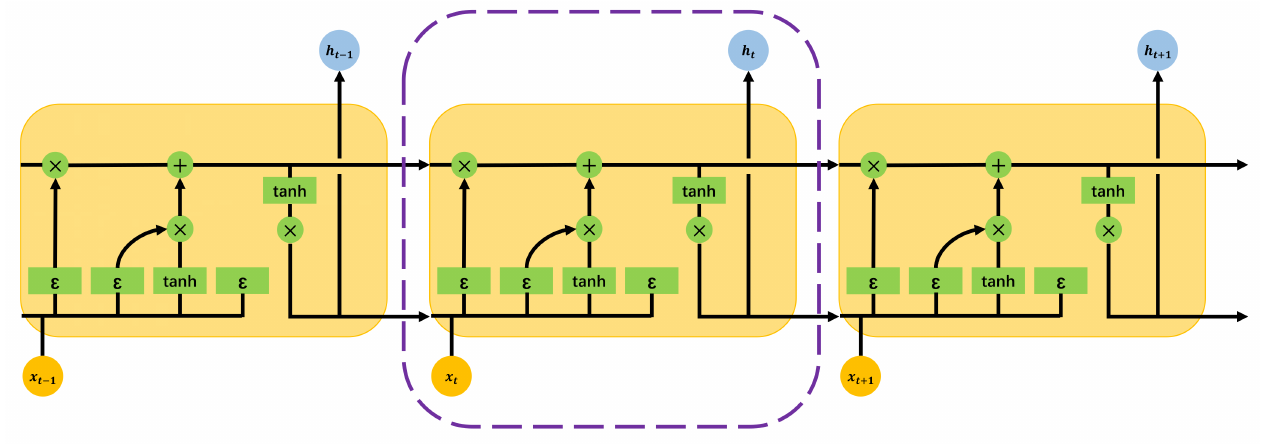
Figure 2. Structure diagram of LSTM. The part inside the purple dotted line represents the core part of the current network operation. The left side outside the purple dotted line is the operation of the previous time period, and the right side is the operation of the next time